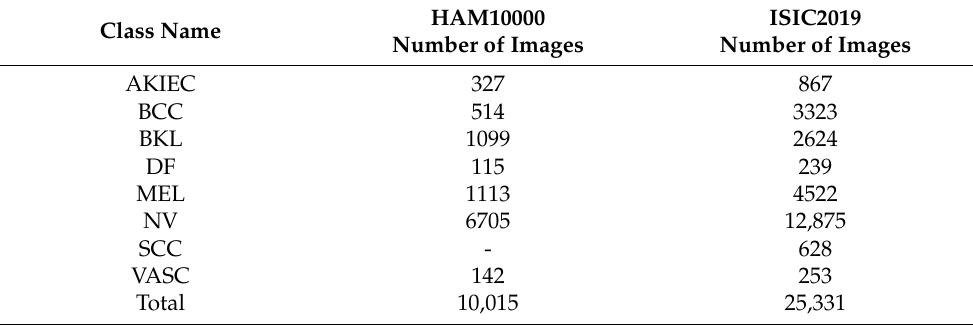
Table 2. Class distribution in the HAM10000 and ISIC 2019